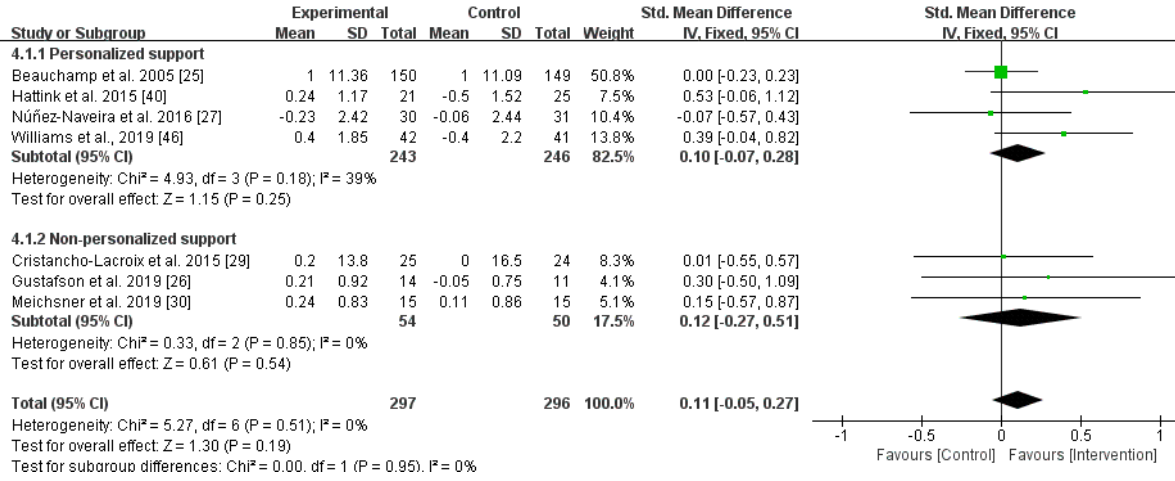
Figure 6. The effect of internet-based supportive interventions on coping competence.